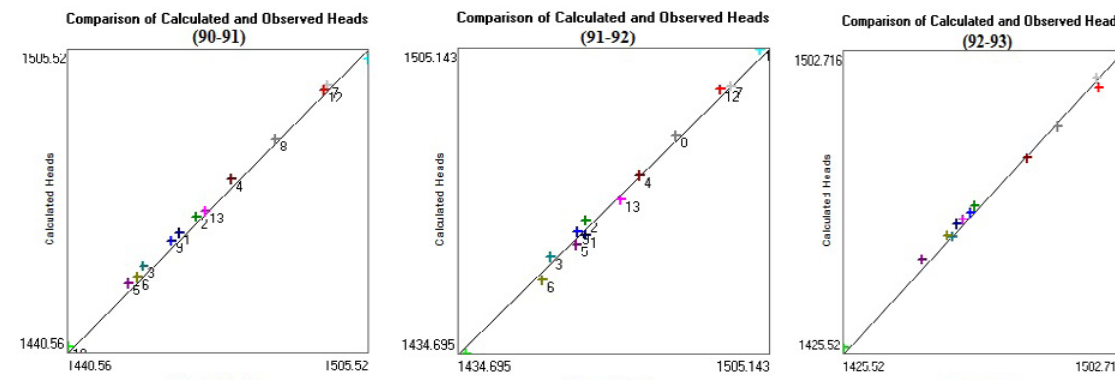
Figure 4. Observational and computational head of calibration in different years